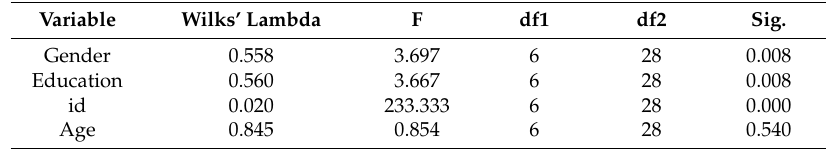
Table 2. Tests of equality of group means.